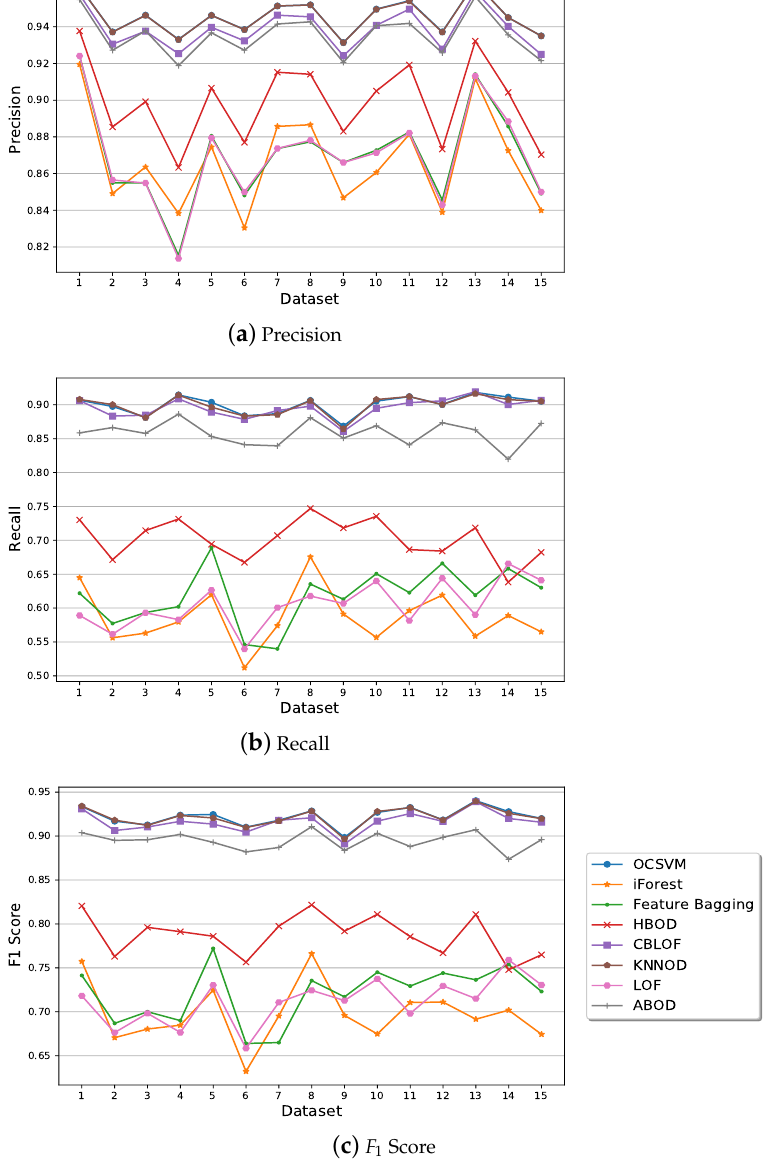
Figure 12. Performances of semi-supervised anomaly detection algorithms using all features in terms of average precision, recall, and F 1